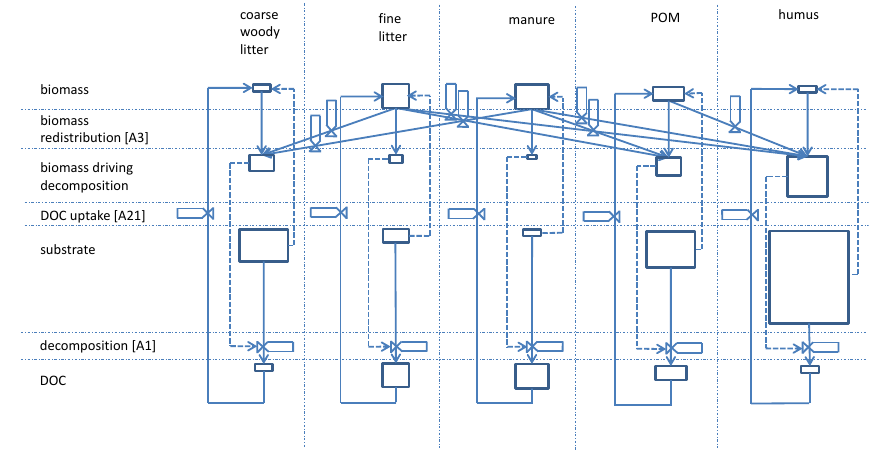
Fig. 1. Conceptual model for priming implemented in ecosys . Biomass in each of five substrate–microbe complexes (coarse woody litter, fine litter, manure, particulate organic matter (POC) and humus) is driven by uptake of DOC from decomposition. This biomass is then redistributed across these complexes according to biomass:substrate ratios in each complex. The redistributed biomass then drives decom- position. Expressions in brackets refer to equations in the Supplement. Boxes represent state variables, sizes of which indicate relative sizes of biomass or substrate in each complex. Solid lines with valves represent rates of transfer among states; dashed lines represent drivers of these